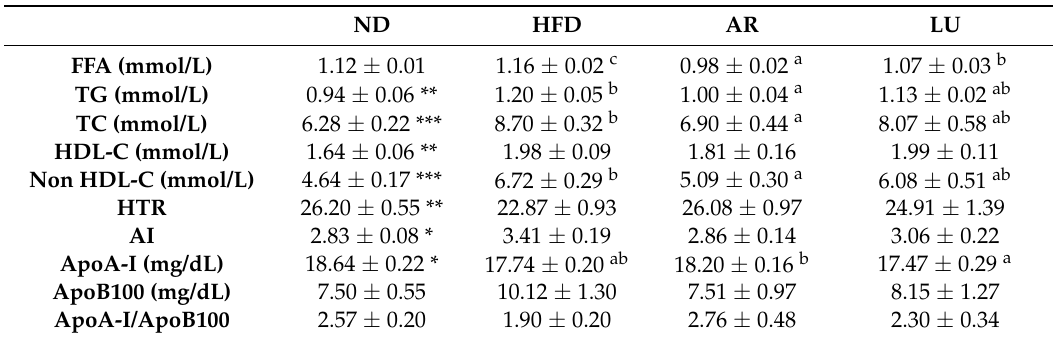
Table 2. Effects of luteolin-enriched artichoke extract and luteolin supplementation on the plasma lipid levels in C57BL/6N mice fed a high-fat